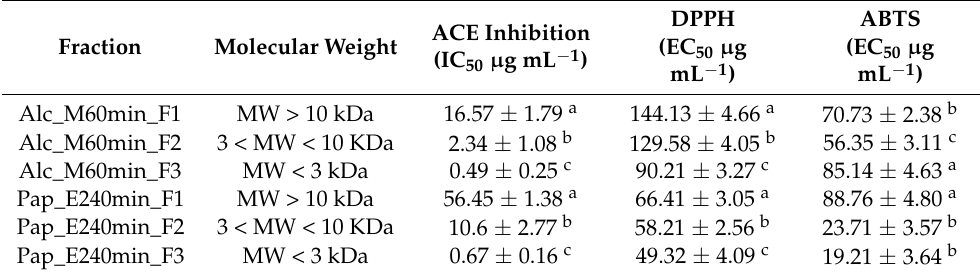
Table 2. ACE inhibition and antioxidant activities of Alc_M60min and Pap_E240min hydrolysates’ ultrafiltrate